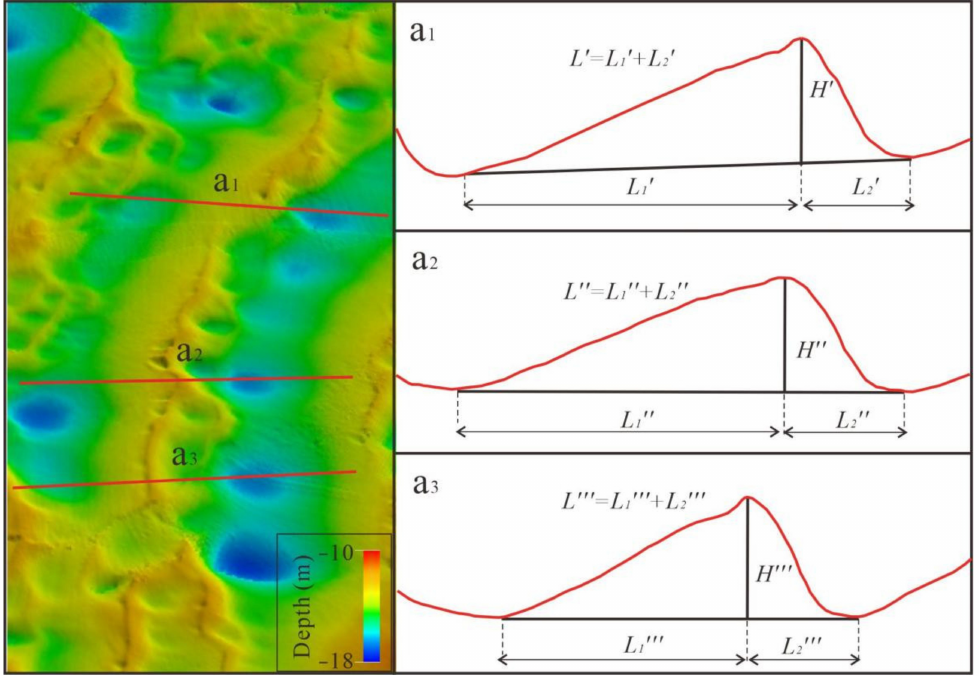
Figure 2. Map and statistical methods for measuring of catenary-bead dunes. ( a 1 – a 3 ) represent the cross-sections of one catenary-bead dune. H ’– H ”’ and L ’– L ”’ are the measured dune height and length,